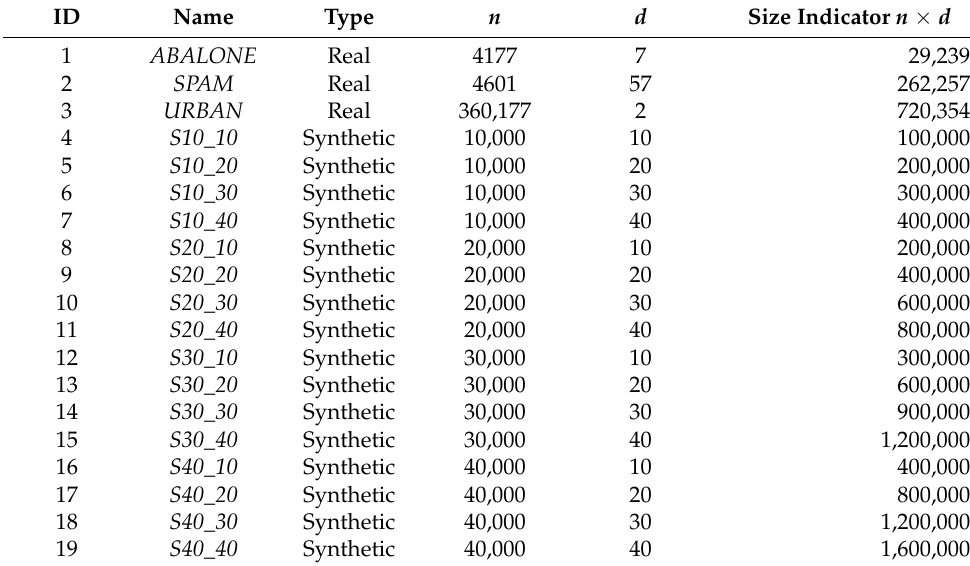
Table 2. Datasets used in